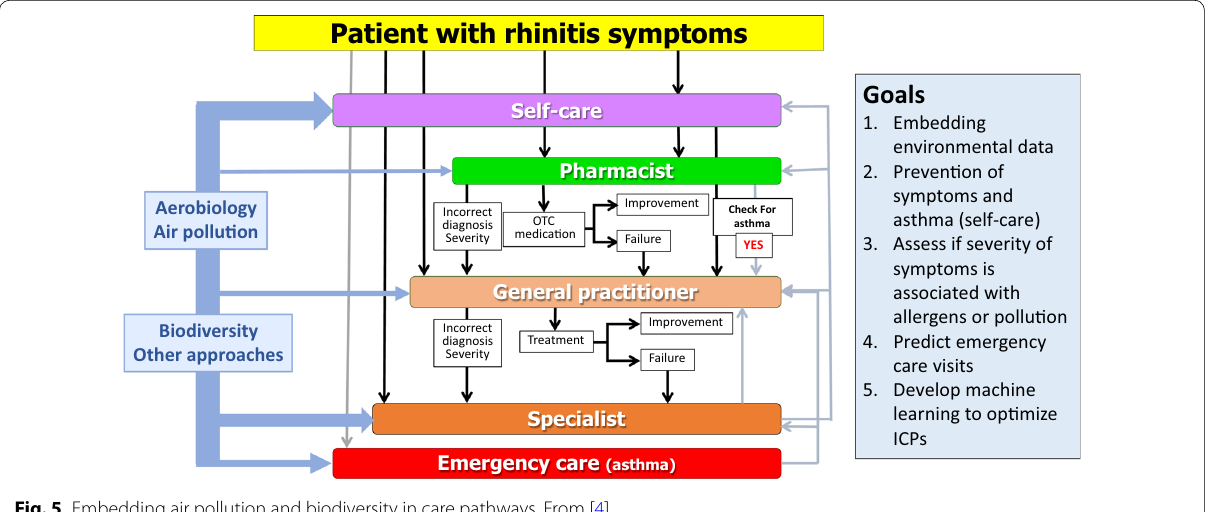
Fig. 5 Embedding air pollution and biodiversity in care pathways. From [4]